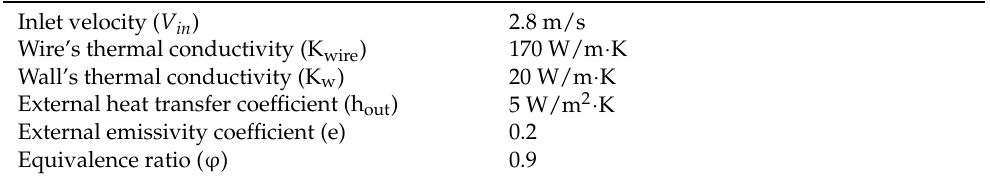
Table 1. Some of the applied values in the study.